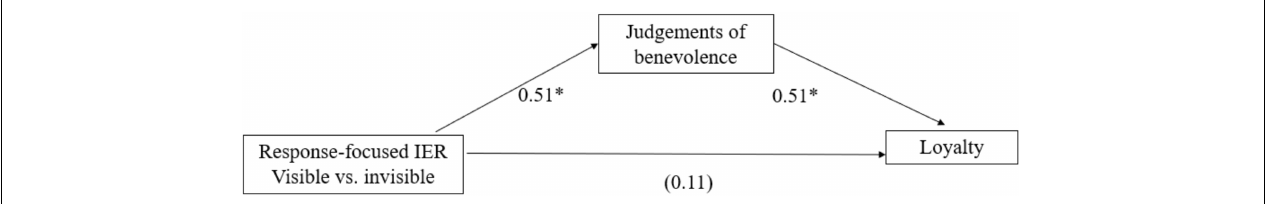
FIGURE 5 | The mediating role of judgments of benevolence in Study 5. * p <